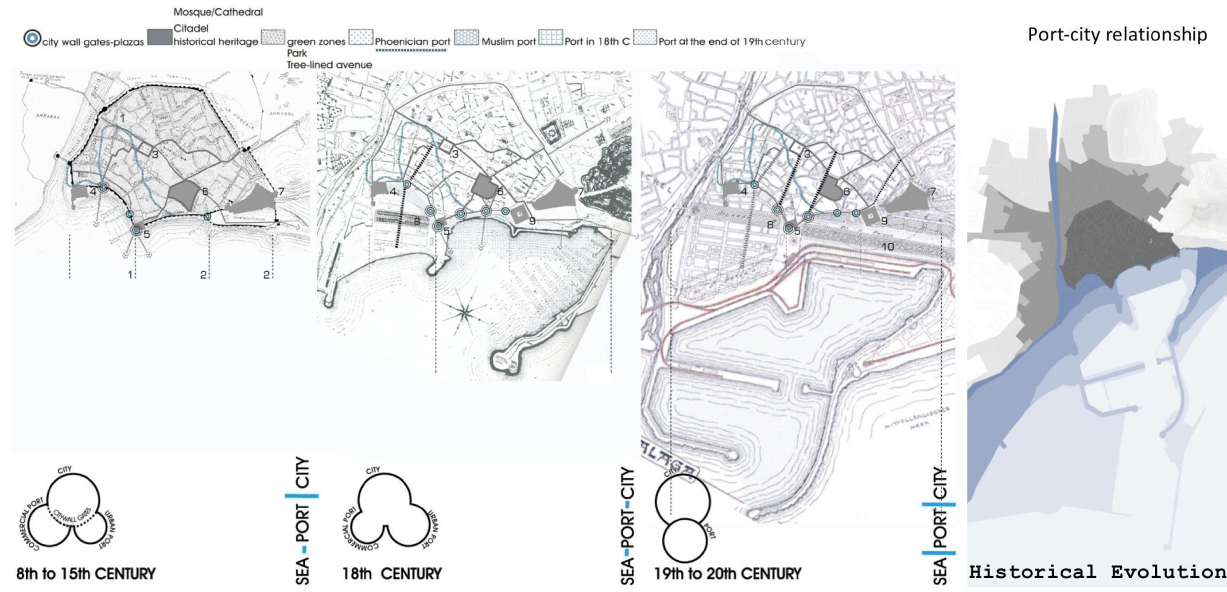
Figure 3. Historical evolution of the port‐city relationship of Malaga: Muslim Malaga, 8th to 15th centuries; 18th cen‐ tury, demolition of the ramparts; 19th century, Industrialisation. Notes: 1. Commercial Port; 2. Urban Port; 3. Plaza de la Constitución; 4. Shipyards (currently the market); 5. Castle of the Genovese (currently the Plaza de la Marina); 6. Mosque/Cathedral; 7. Fortress/Arab Citadel; 8. Alameda; 9. Customs House (currently the Museum); 10. Park. Source: María J. Andrade